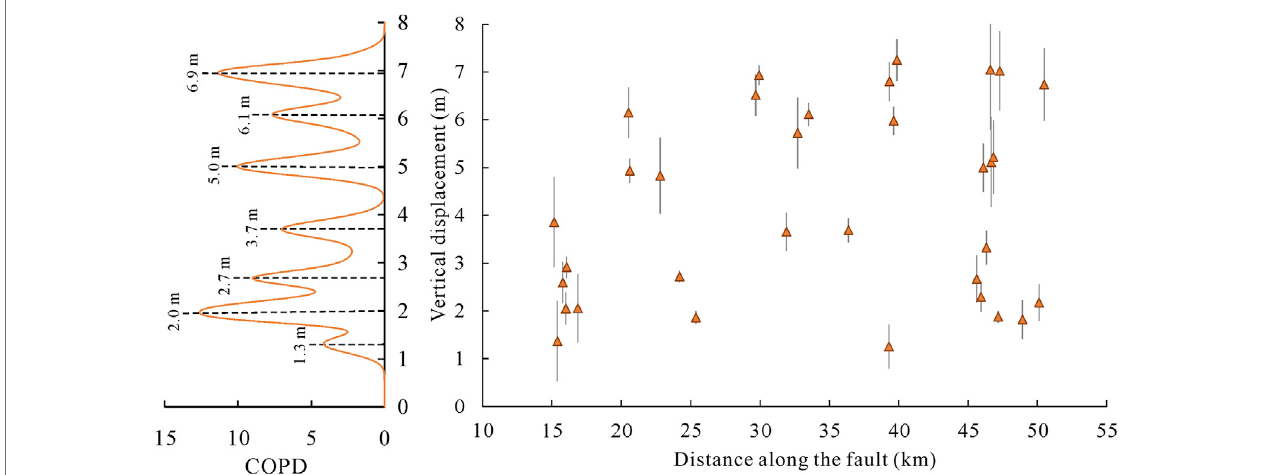
FIGURE8 | Statistical analysis of theverticaldisplacements on the Gongmiaozi-Heshunzhuangsegmentin the range of0 – 8 m. Each displacement is represented by a Gaussian PDF. Adding up the PDFs of all displacements forms the COPD curve which generally shows several peak shapes, and each peak may indicate an individual earthquake.